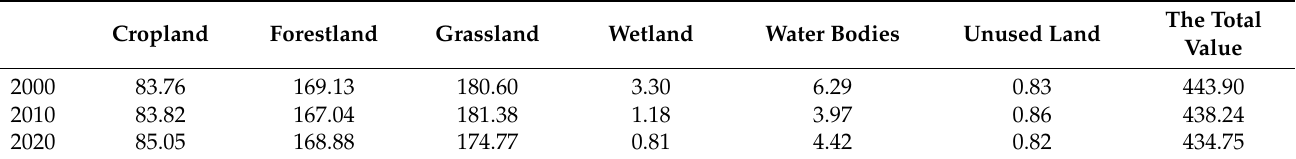
Table 3. ESV of the Loess Plateau in Northern Shaanxi. Unit: CNY 100